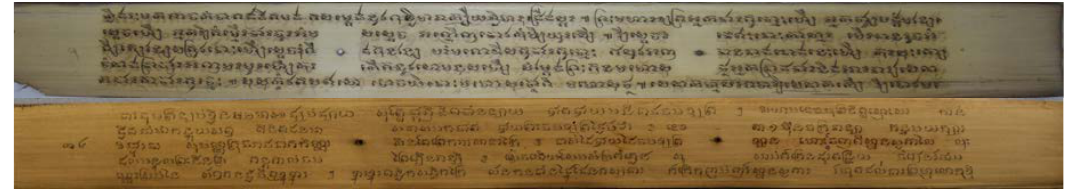
Figure 2. Khmer palm leaf manuscript.